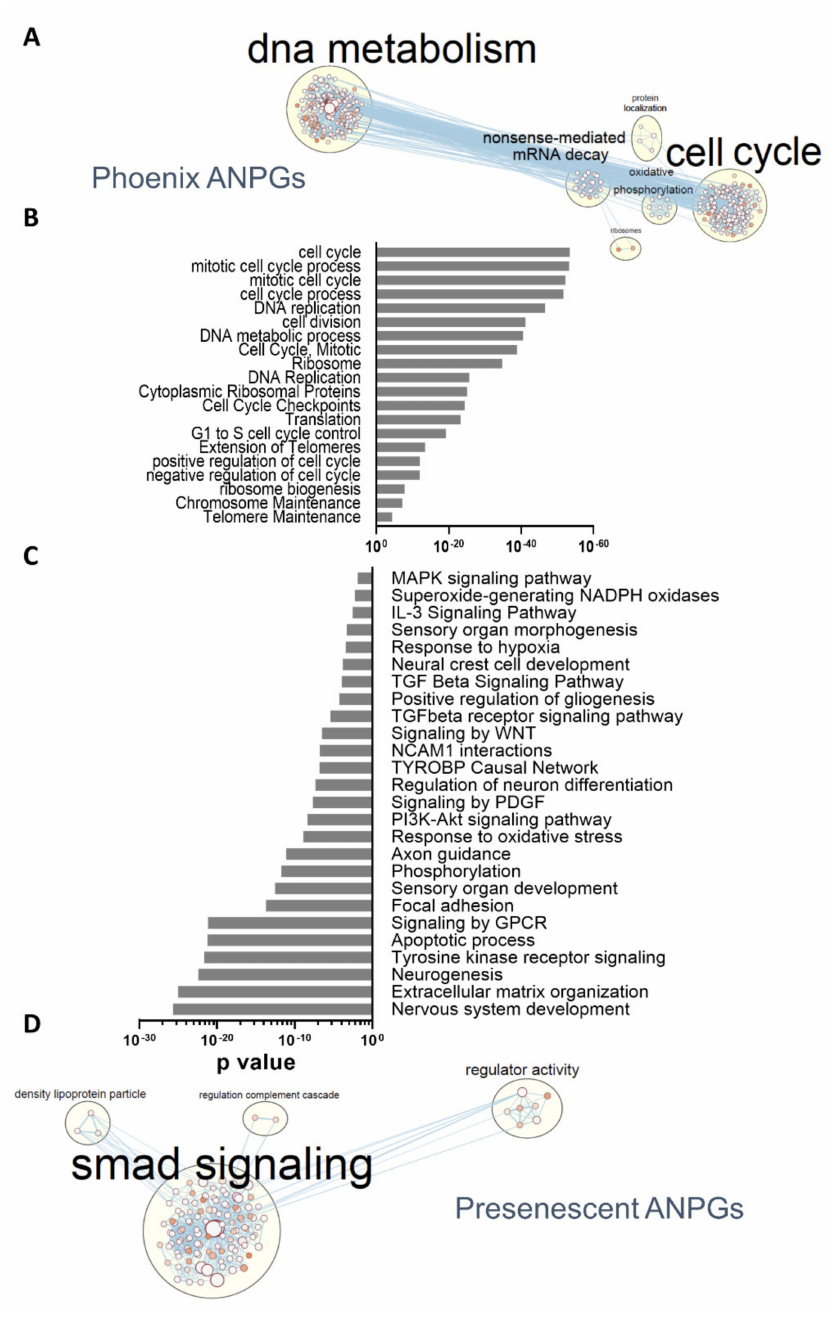
Figure 4. Differentially represented gene ontologies between phoenix and presenescent ANPGs . ( A ) Gene ontology network from ( B ). Each node represents a GO term, edges are drawn when there are shared genes between two GO terms. ( B ) Main relevant gene ontologies enriched in phoenix ANPGs vs. C57Bl/6 and A/J ANPGs. ( C ) Main relevant gene ontologies showing a significantly enrichment in C57Bl/6 and A/J ANPGs vs. phoenix ANPGs. ( D ) Gene ontology network from ( C ). Each node represents a GO term, edges are drawn when there are shared genes between two GO